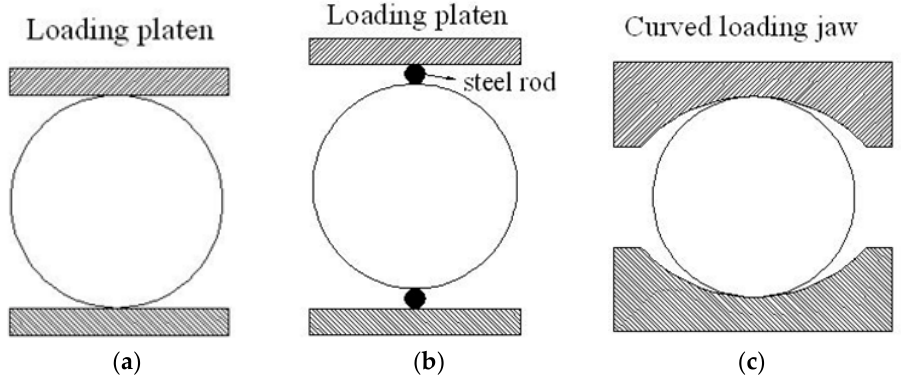
Figure 1. Typical Brazilian tensile test loading configurations: ( a ) flat loading platens; ( b ) flat loading platens with two small diameter steel rods and ( c ) curved loading jaws.